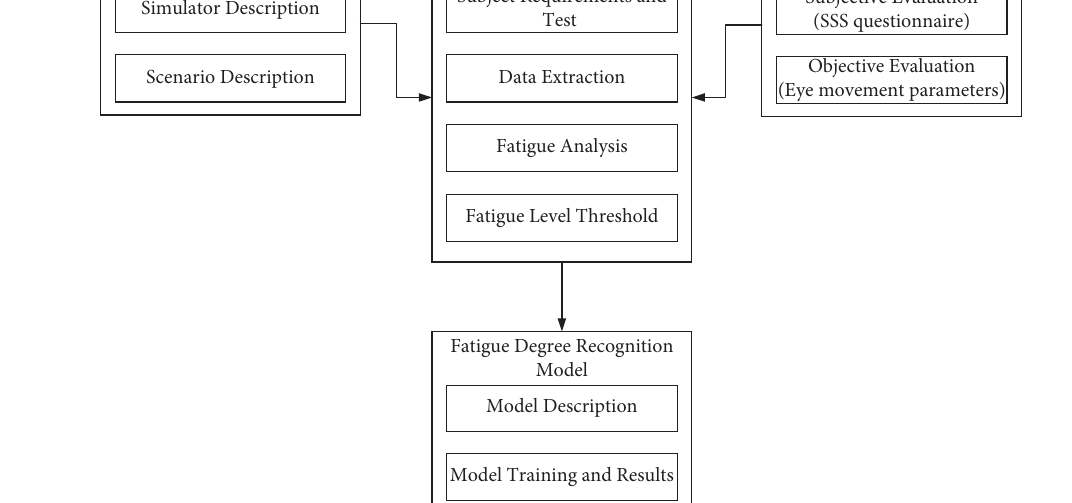
Figure 1: Theoretical